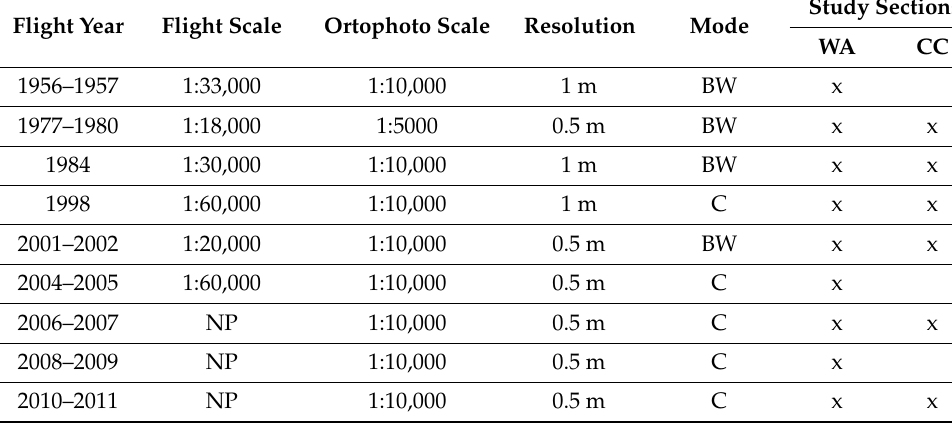
Table A1. Characteristics of the orthophotos used in each section of the diachronic study (WA, wooded area; CC, canopy cover) according to the information obtained from the regional govern- ment: http://www.juntadeandalucia.es/medioambiente/site/rediam/menuitem.aedc2250f6db8 3cf8ca78ca731525ea0/?vgnextoid=0863d61d8470f210VgnVCM2000000624e50aRCRD&lr=lang_es (ac- cessed on 19 July 2020). Orthophotos available from 2004 onwards correspond to odd-numbered years for Gibrale ó n and to even-numbered years for all the other areas. BW: black and white; C: color; NP: unspecified. Flight Year Flight Scale Ortophoto Scale Resolution Mode